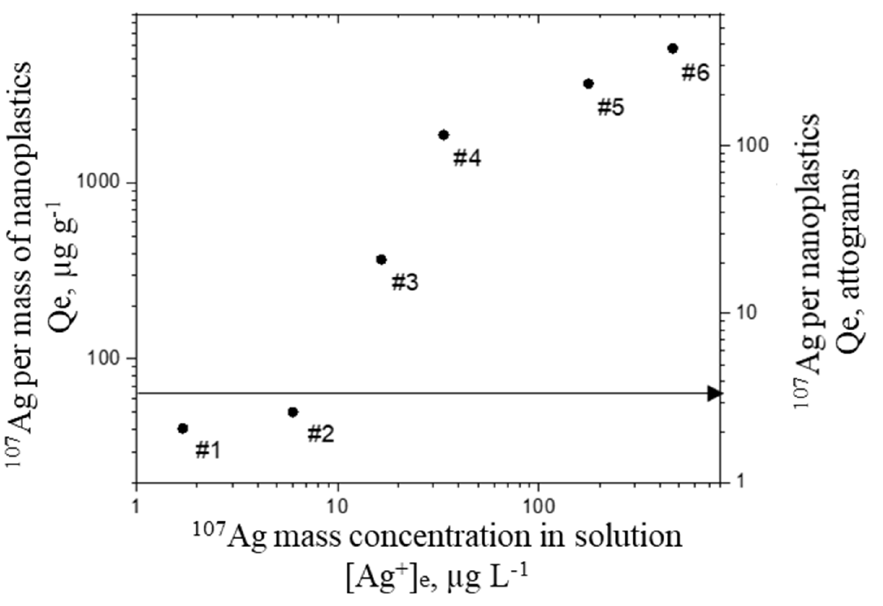
Figure 2. Mass of silver adsorbed onto nanoplastics with respect to the free silver ionic concentration at the equilibrium in different mixtures PSAA22:Ag. The arrow indicates the minimum mass of silver required per nanoplastic for SP-ICP-MS detection.